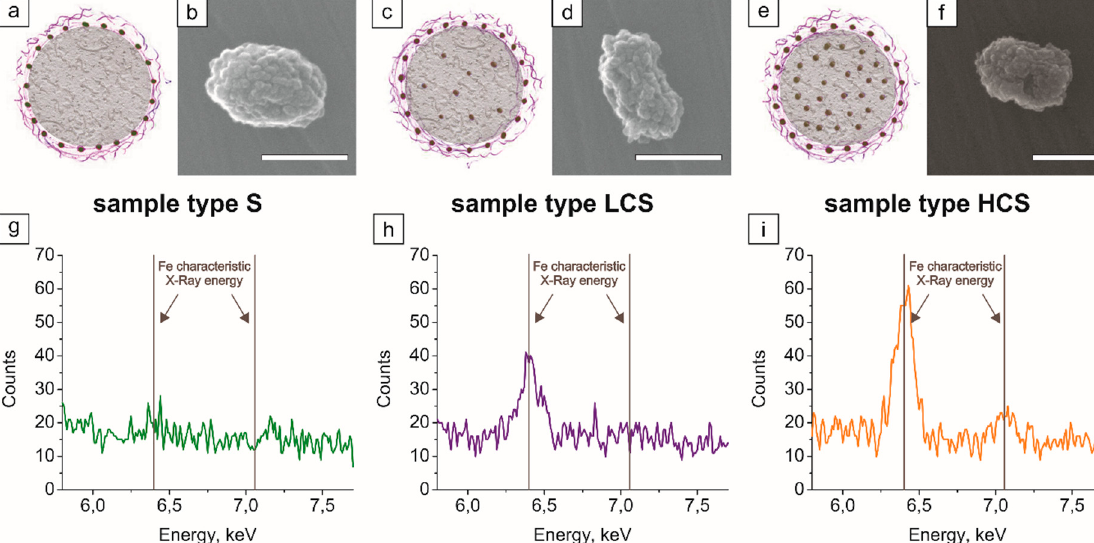
Figure 2. Scheme of ( a ) S, ( c ) LCS, and ( e ) HCS submicron core–shells; SEM images of ( b ) S, ( d ) LCS, and ( f ) HCS and EDX analysis of ( g ) S, ( h ) LCS, and ( i ) HCS samples. Scale bar: 500 nm.